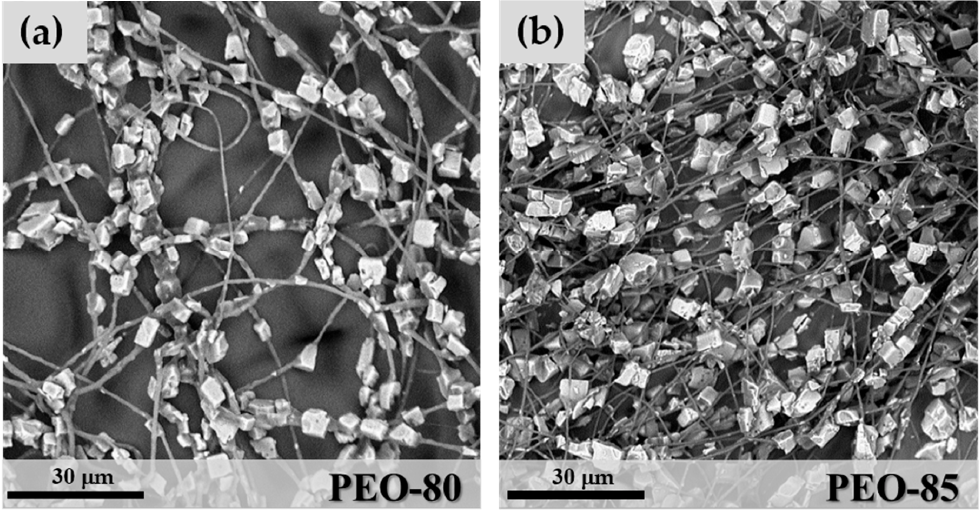
Figure 5. SEM images of sample PEO-80 ( a ) and PEO-85 ( b ).